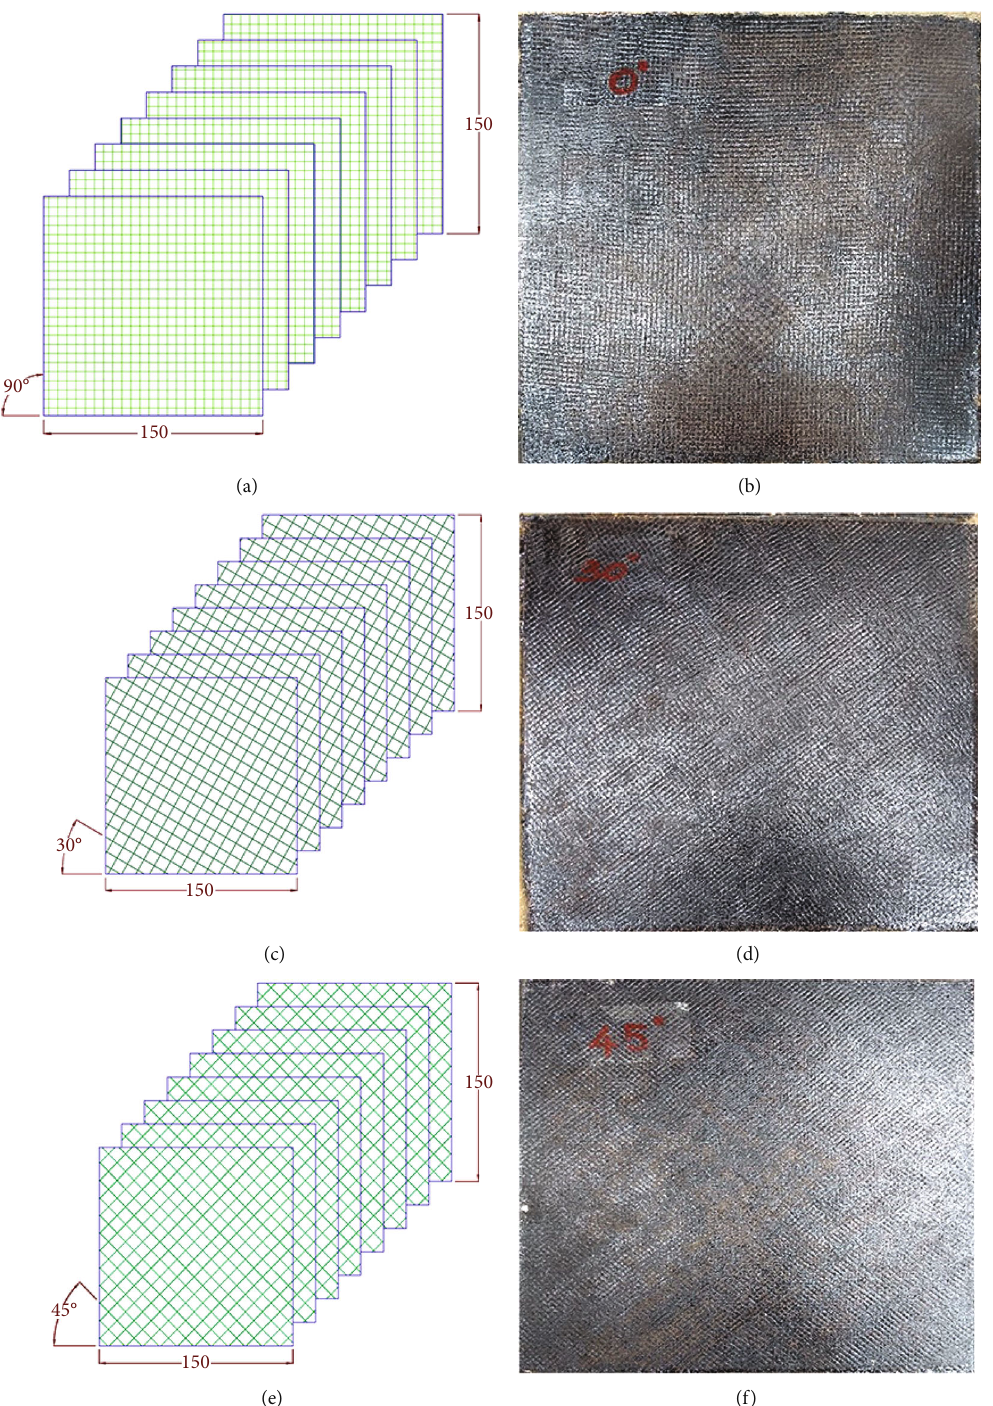
Figure 1: Fabricated basalt fi ber – reinforced anamide composites at di ff erent fi ber orientations (a) and (b) 0 ° /90 ° fi ber orientation, (c) and (d) 30 ° /120 ° fi ber orientation, and (e) and (f) 45 ° /135 ° fi ber